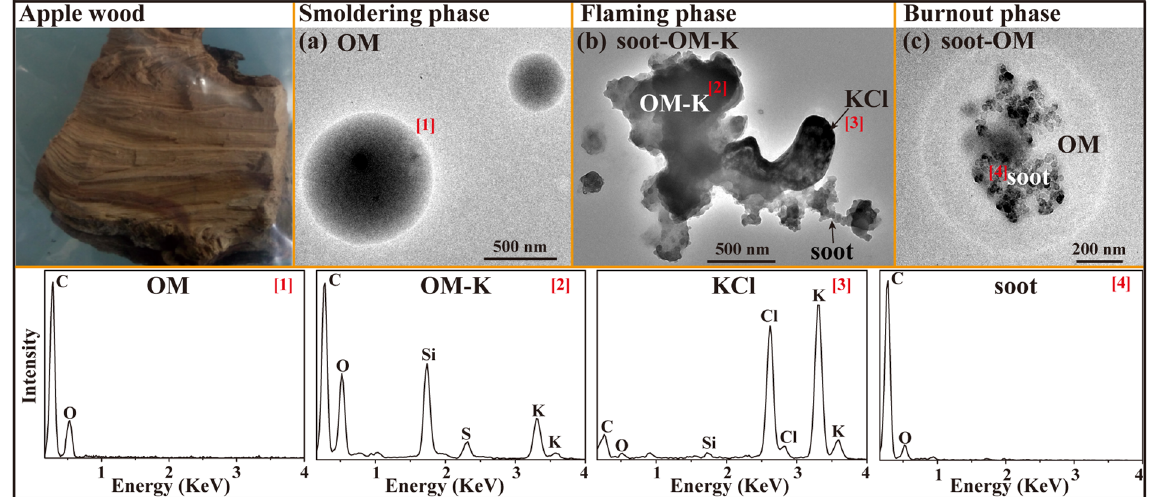
Figure 6. TEM images and EDS spectra of individual primary particles from the combustion of apple wood. ( a ) Two spherical gel-like OM in the smoldering phase; ( b ) An irregular OM particle internally mixed with KCl and soot in the flaming phase; ( c ) A soot particle coated by gel-like and transparent OM in the end of flaming (burnout) phase. The corresponding EDS spectra are indicated by the number in square